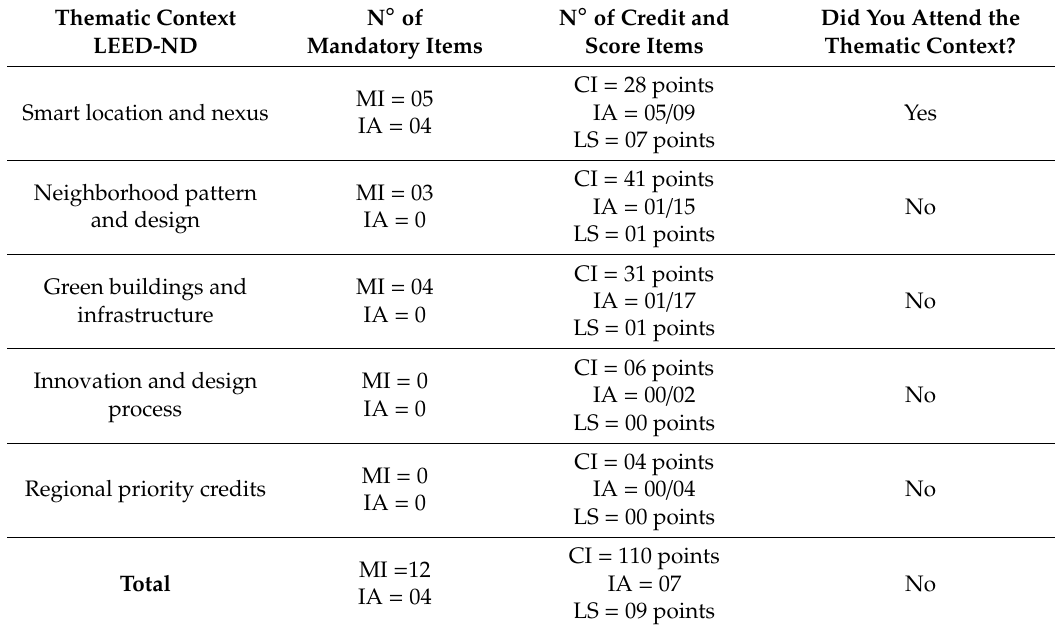
Table 6. Number of mandatory items (MI), number of items attended (IA), number of max credit items for certification (CI), and LEED-ND score (LS).